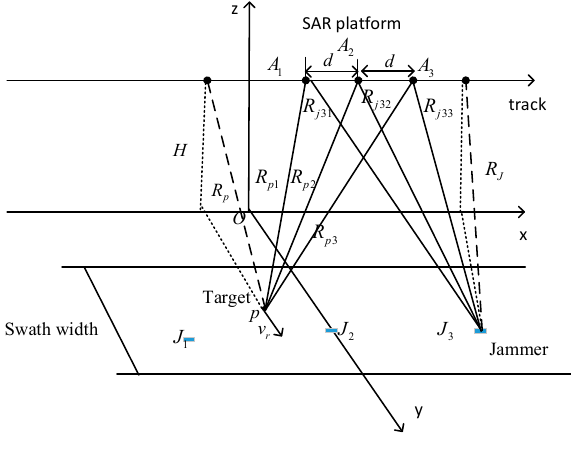
Figure 1. Geometry of three-channel SAR-GMTI.